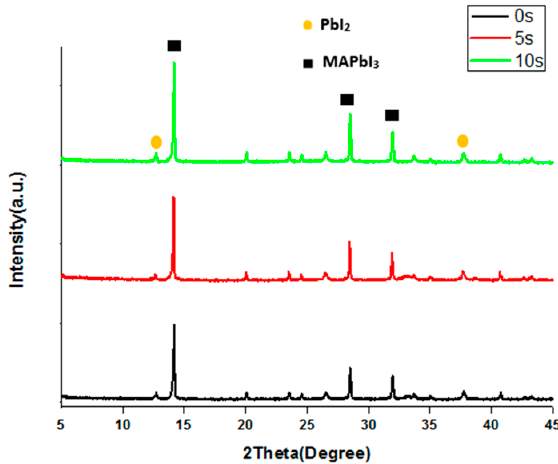
Figure 2. The X-ray diffraction (XRD) patterns of the light-absorbing layer film with different delay